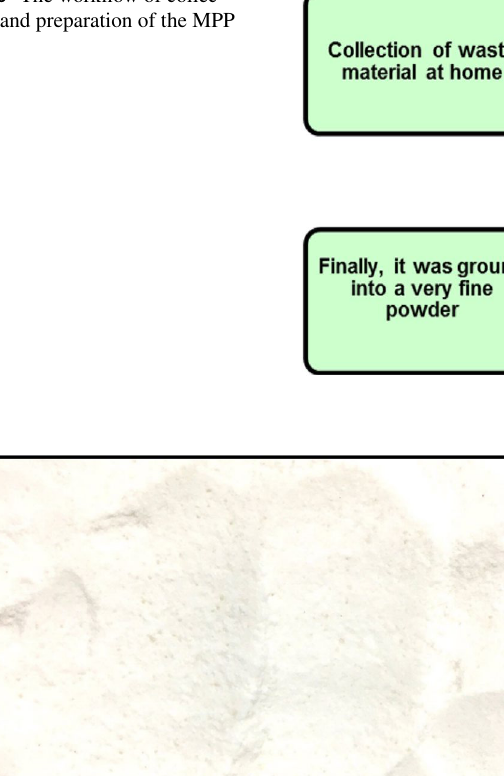
Fig. 6 The workflow of collec- tion and preparation of the MPP